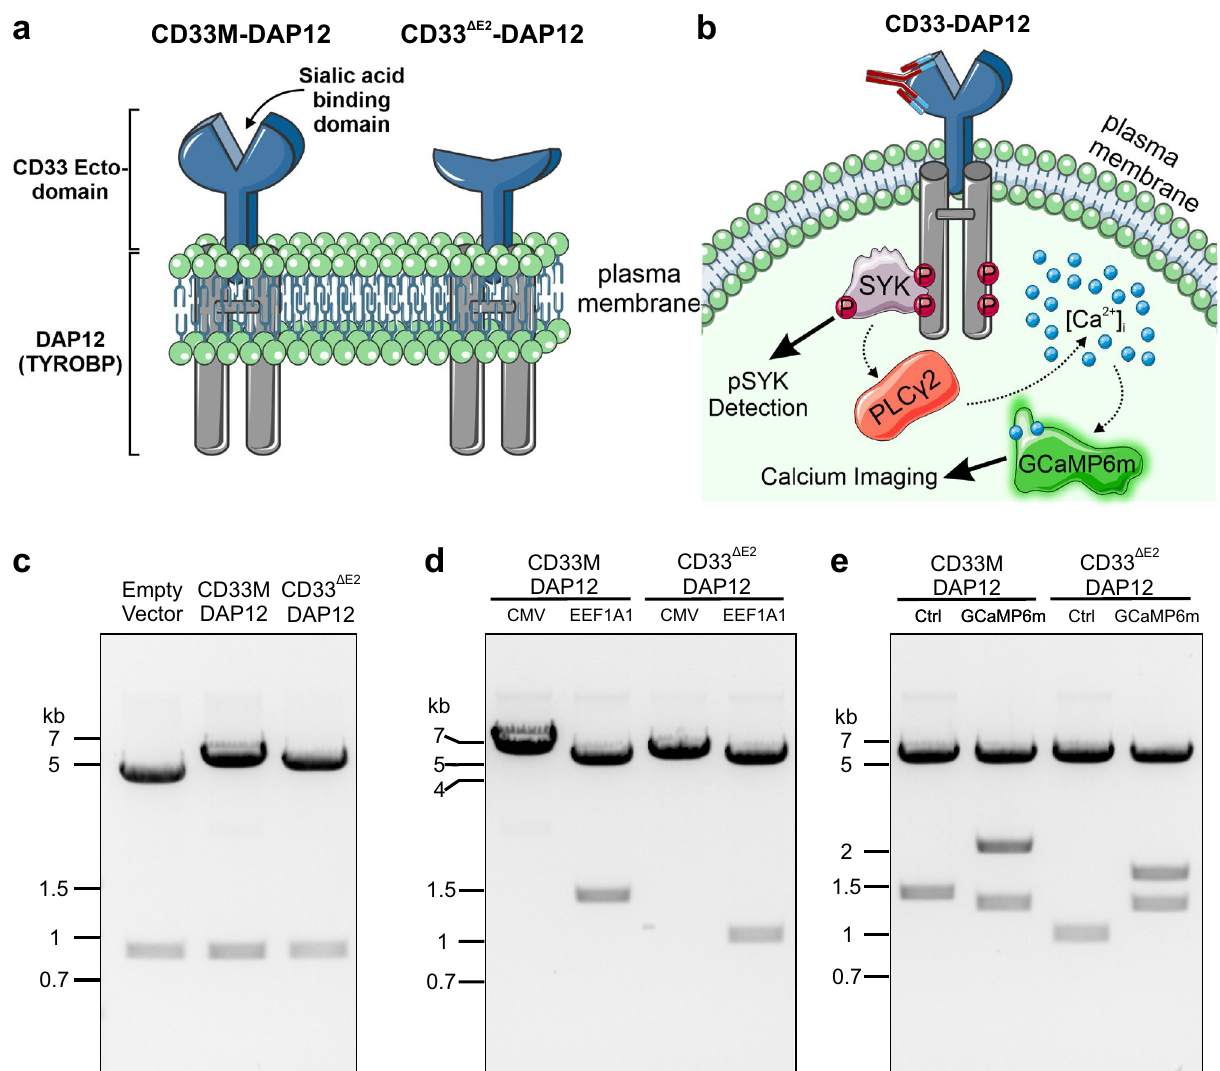
Figure 1. CD33 reporter cell line constructs. ( a ) Schematic drawing of the two CD33-DAP12 constructs. Both, the full CD33 ecto-domain (CD33M) and the ecto-domain lacking the sialic acid binding domain (CD33 ΔE2 ) were fused to TYROBP/DAP12. ( b ) Schematic drawing of the readouts for the CD33 reporter cell line. CD33 can be activated by ligands or antibodies, which results in increased SYK phosphorylation and consequently increased intracellular calcium levels. ( c ) Gel electrophoresis image of CD33-DAP12 constructs cloned into pcDNA5/ FRT after digestion by EcoRI. ( d ) Successful exchange of the viral CMV promoter with the human EEF1A1 promoter was indicated by a second band after digestion with XhoI at 1,339 bp (CD33M) or 958 bp (CD33 ΔE2 ). ( e ) Gel electrophoresis image of pcDNA5/FRT-CD33-DAP12-GCaMP6m plasmids after digestion with XhoI. GCaMP6m positive clones exhibited three bands compared to the control (Ctrl) with only two bands. Gel images were cropped for better visualization. Supplementary Fig. 1 shows the uncropped full-length